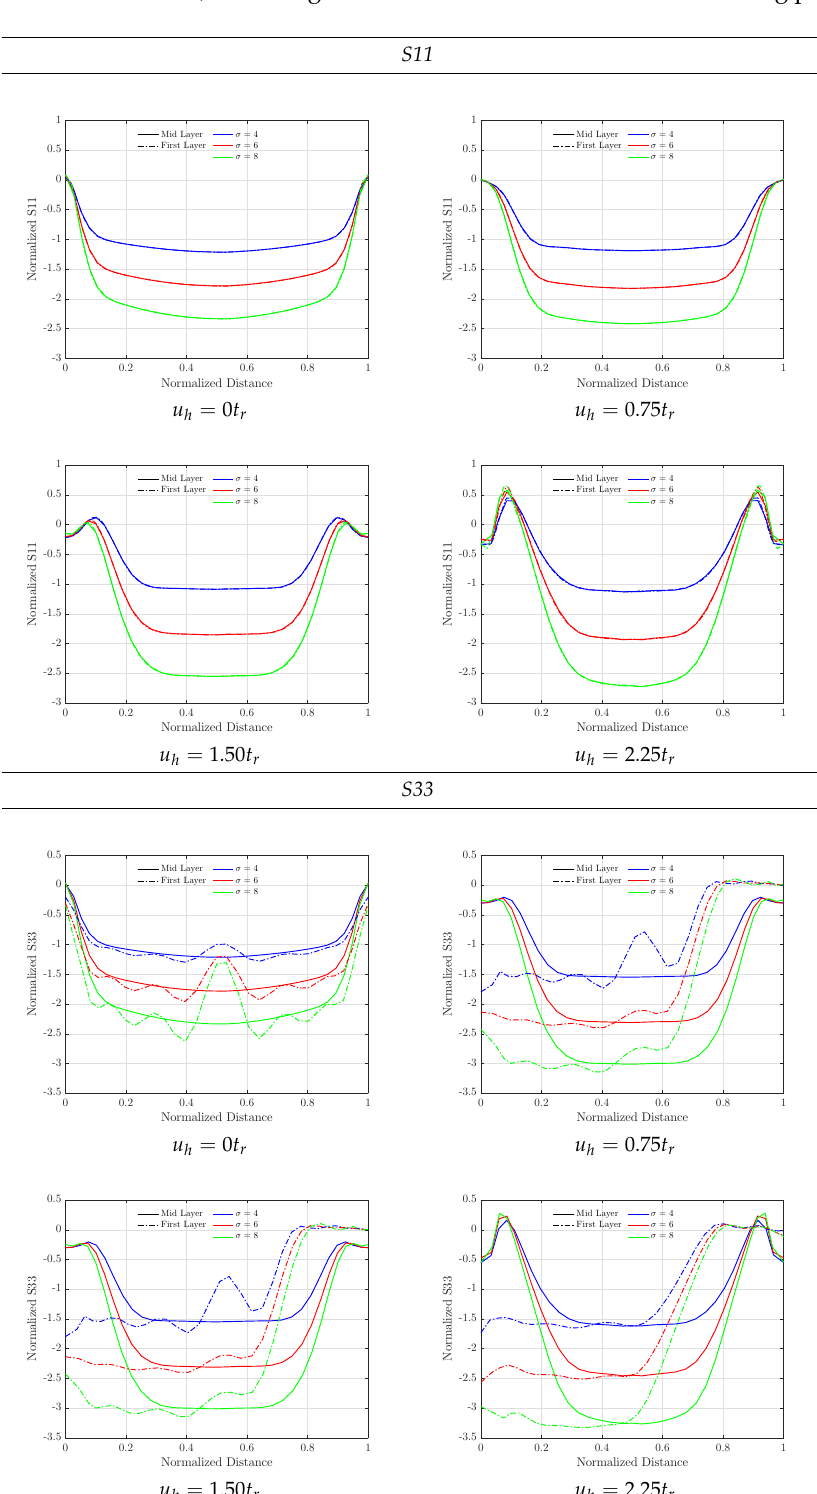
Figure 25. Normal axial S11 and vertical S33 stresses along the symmetry axis. Effect of vertical pressure P